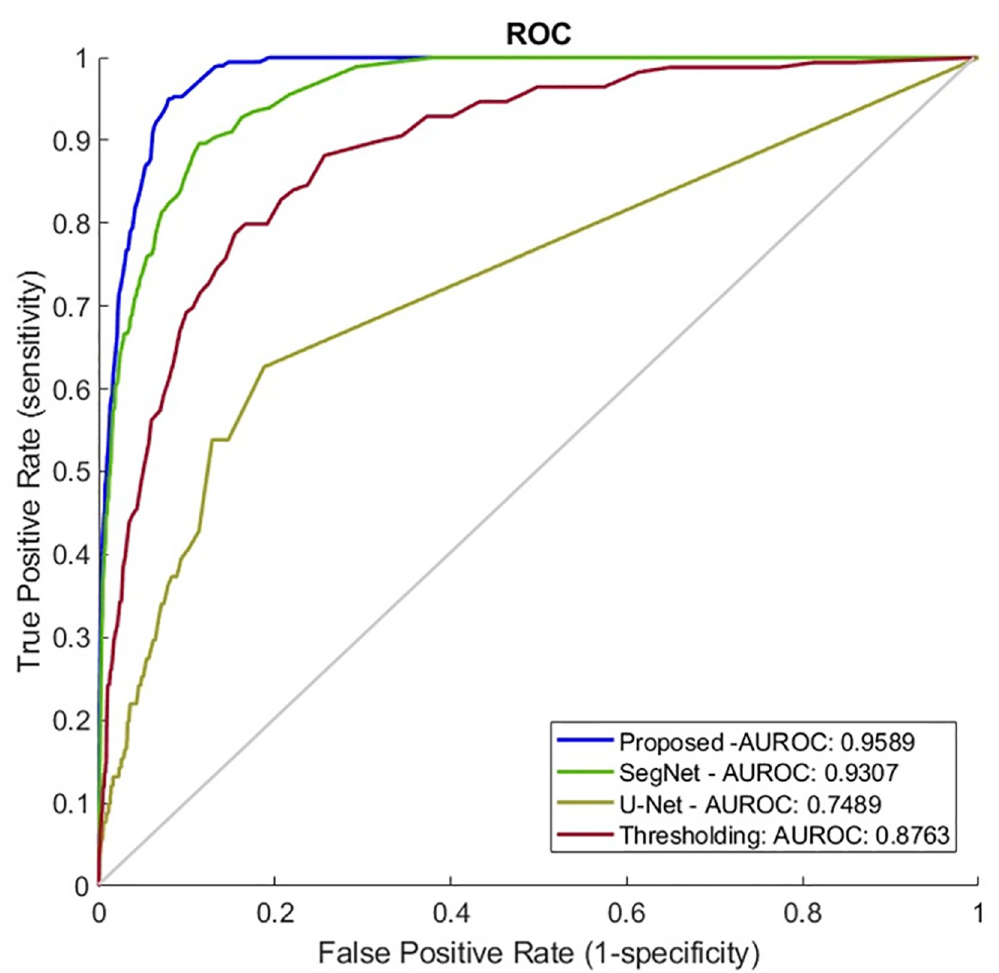
Fig 5. Performance comparison on external validation analysis. AUROC, area under the receiver operating curve as shown in the image; FPR, false positive rate; TPR, true positive rate.